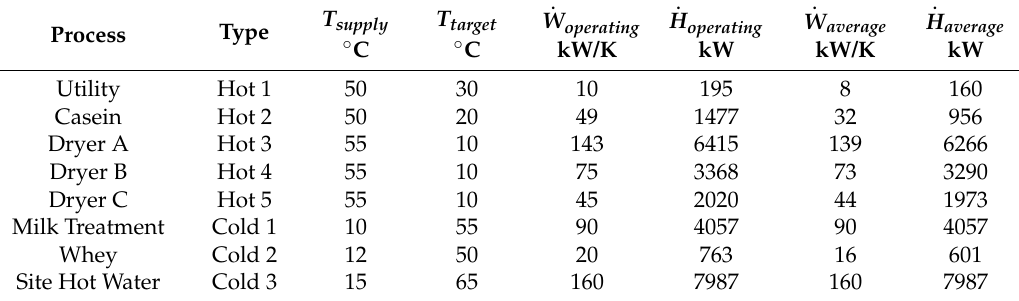
Table 2. Stream table of dairy case study, producing milk powder and cream [11].